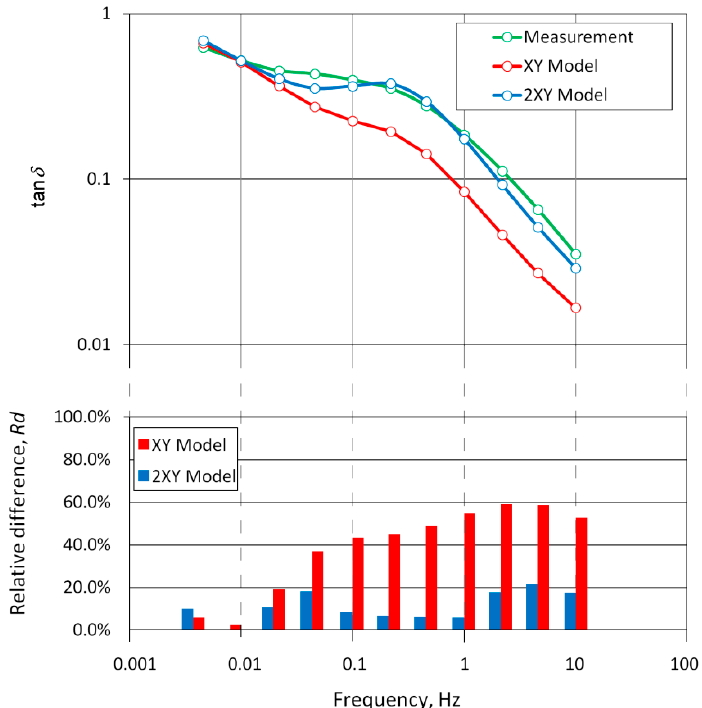
Figure 14. The dependence of the loss tangent on the frequency, measured for the OS type ( U n = 110 kV) bushing insulator and calculated based on the XY and 2 XY models, with the calculated relative differences between the measured and calculated values for both models.